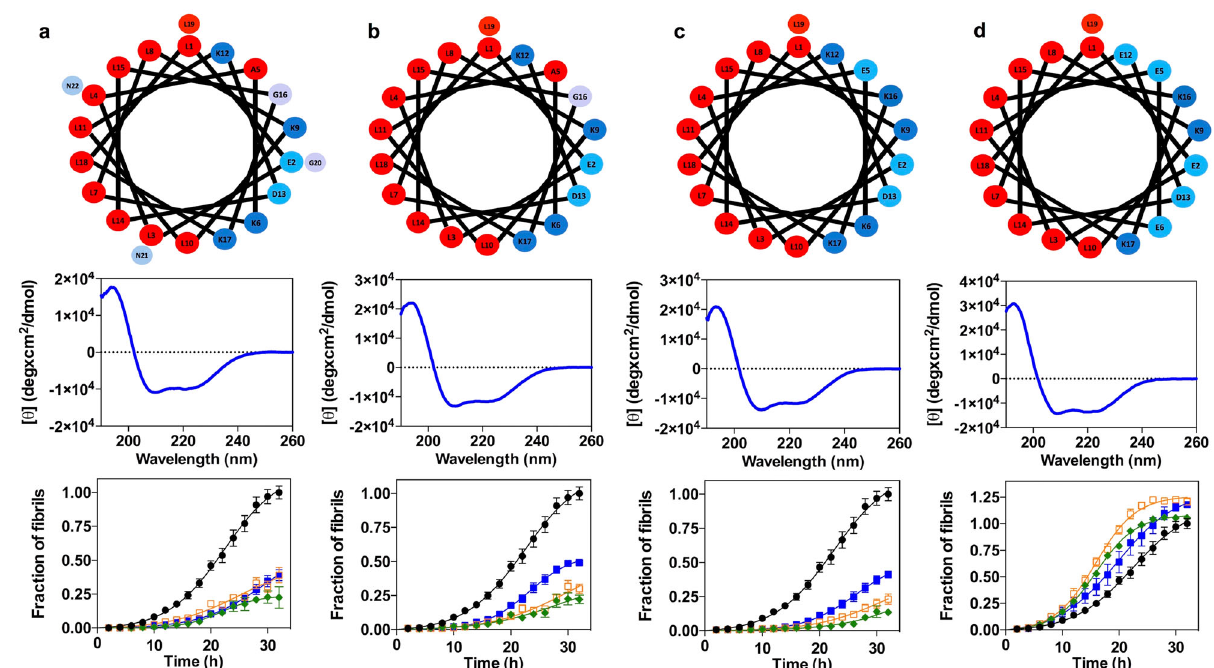
Fig. 5 Redesign of PSM α 3 variants to dissect the molecular determinants of the anti-aggregative activity. a – d Helical wheel (red, hydrophobic residues; blue pallet, hydrophilic residues) (up), circular dichroism spectra (mid) and titration of the inhibitory activity of PSM α 3 variants at different concentrations (down): 35 μ M (green), 14 μ M (orange), 7 μ M (blue) and in the absence of PSM α 3 variants (black). Variants: All_Leu ( a ), All_Leu19 ( b ), Scaffold_19 ( c ), and Anionic_scaffold ( d ). Data were expressed as mean ± s.e.m ( n = 9 independent